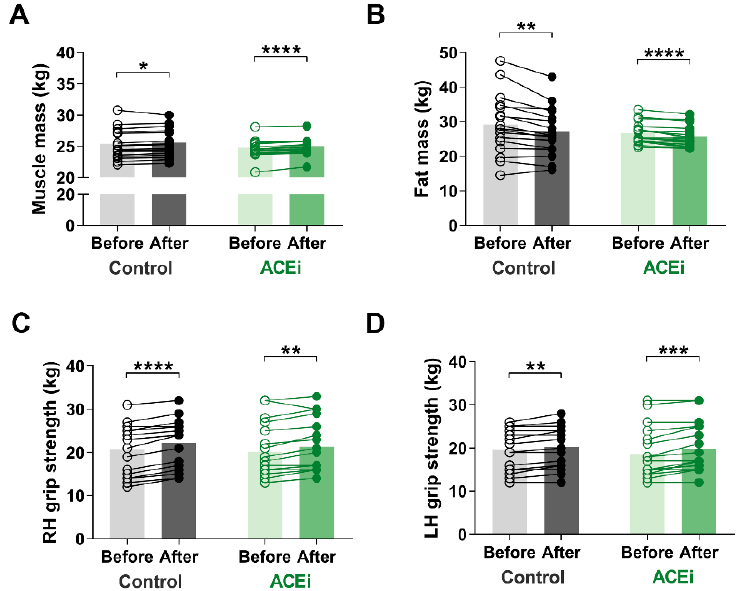
Figure 2. The effects of 6-month functional training program on muscle mass and function in elderly females with sarcopenia. ( A ) Muscle mass. ( B ) Fat mass. ( C ) Right hand (RH) grip strength. ( D ) Left hand (LH) grip strength. Statistically significant differences are defined as * p < 0.05; ** p < 0.01; *** p < 0.001; **** p < 0.0001.